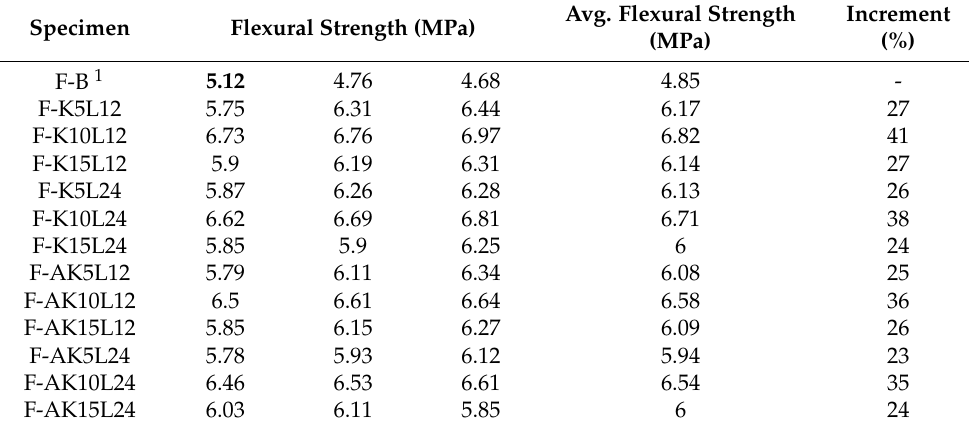
Table 8. Flexural strengths of the benchmark and KFRC specimens under various percentages (5 ‰, 10 ‰, and 15 ‰).